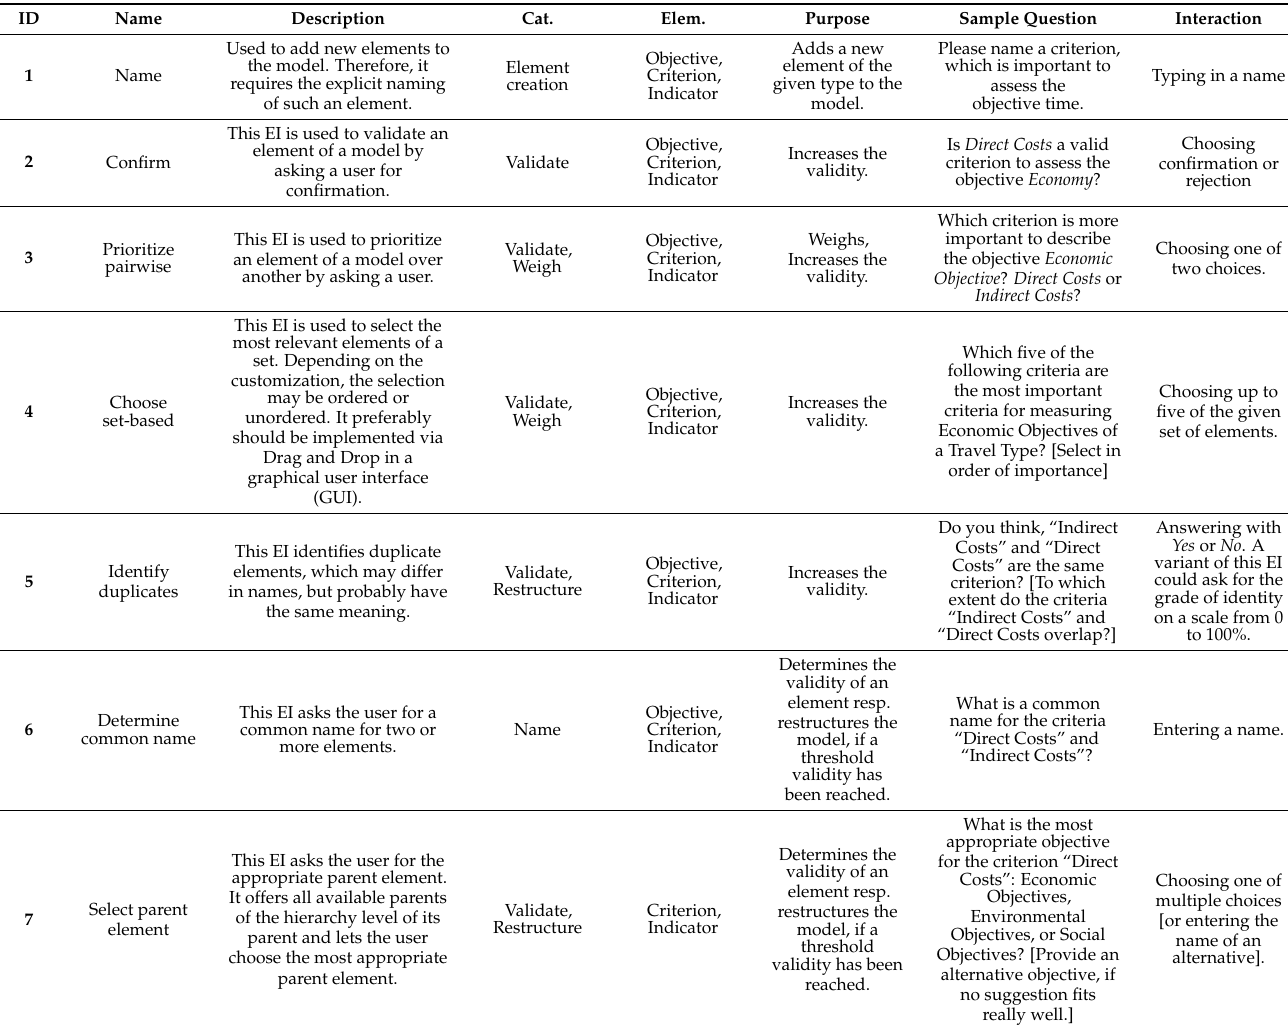
Table 2. Overview of Elementary